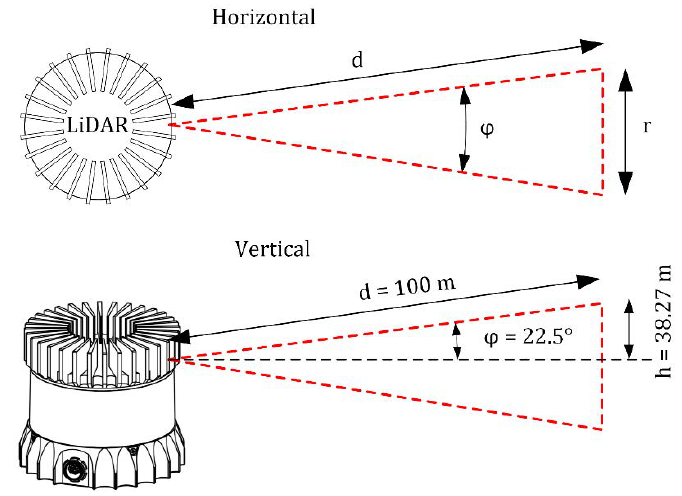
Figure 1. Up: Horizontal distance between two laser beams as a function of distance. Down: Vertical field of view as a function of distance (100 m).